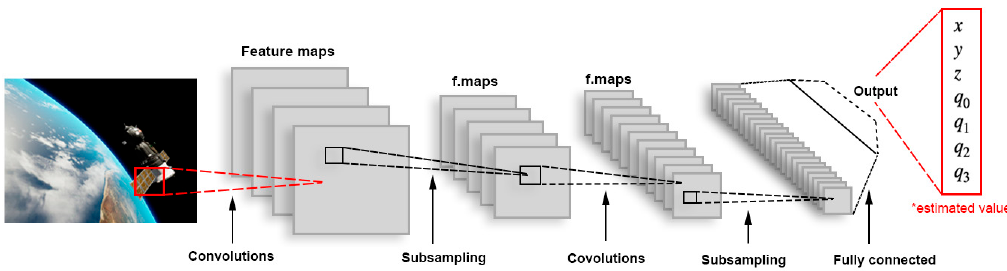
Figure 4. Vision-based pose estimation through the convolutional neural network (CNN) model.